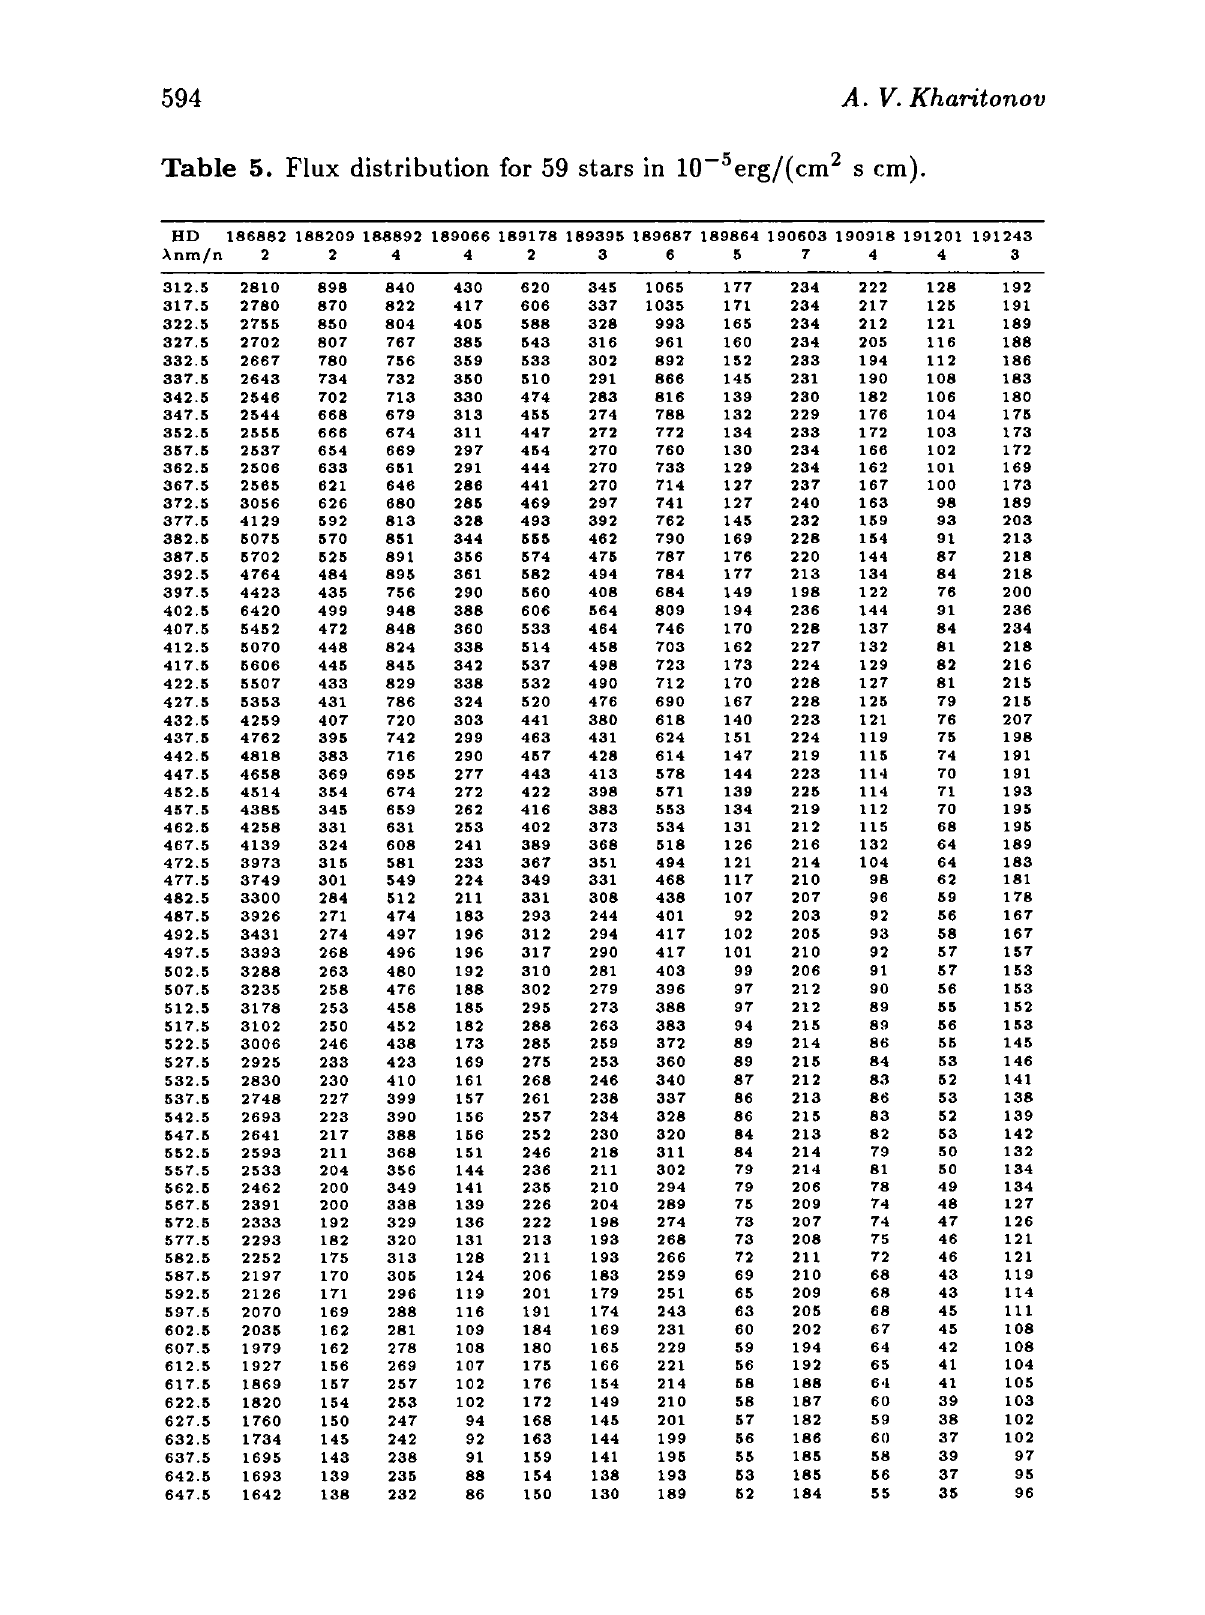
Table 5. Flux distribution for 59 stars in 10 -5 erg/(cm 2 s